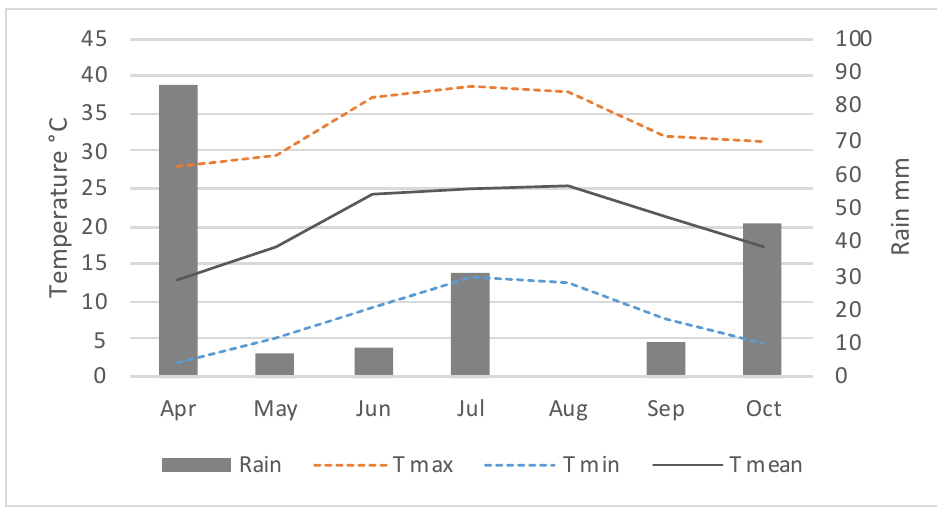
Figure 2. Meteorological data for the study area (April – October 2019).